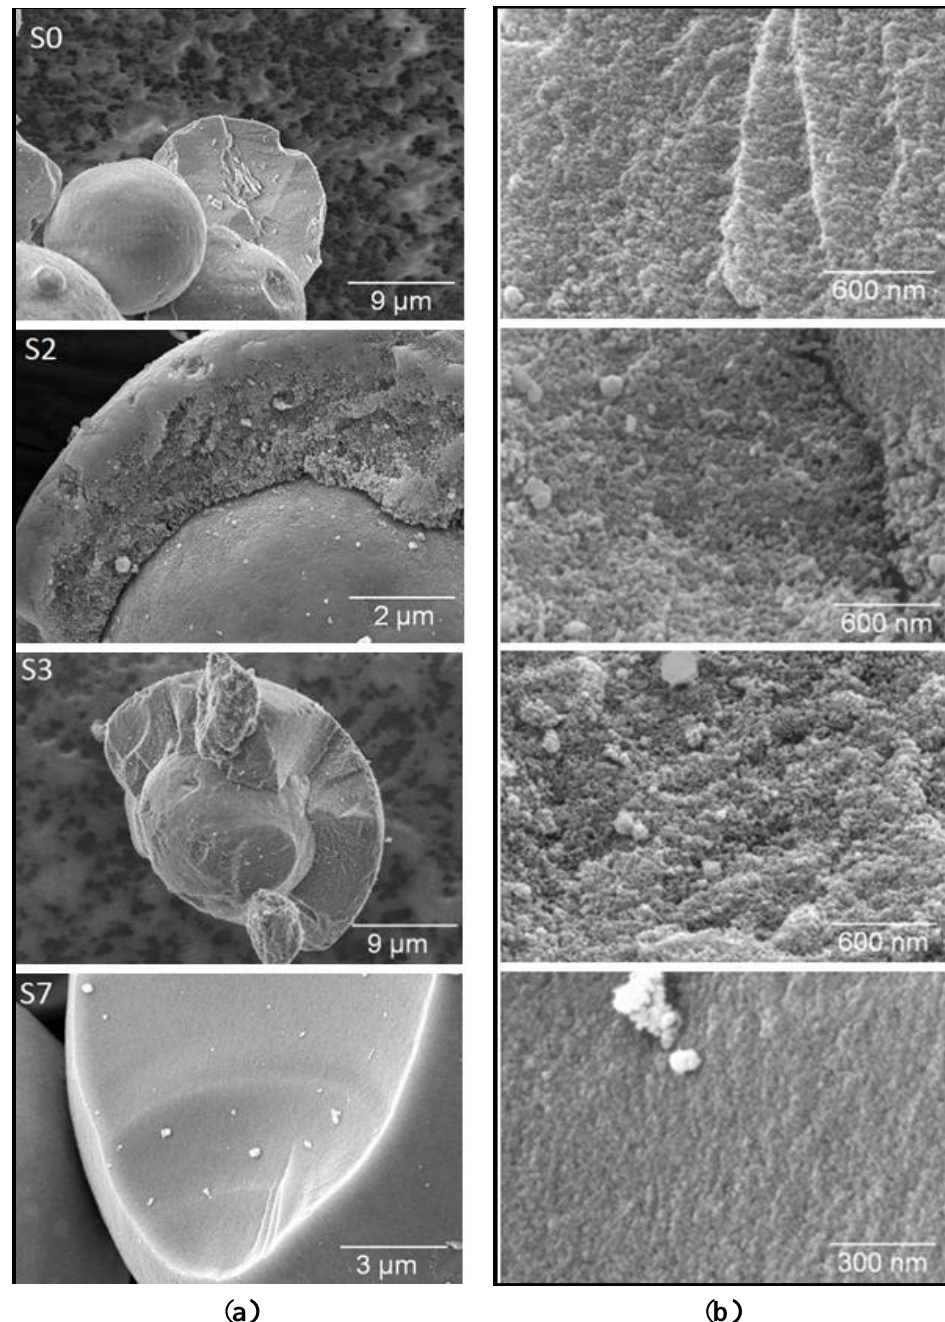
Figure 6. SEM images of ( a ) broken spheres; and ( b ) the view of the broken surface for the initial silica gel S0 and the transformation products S2, S3 and